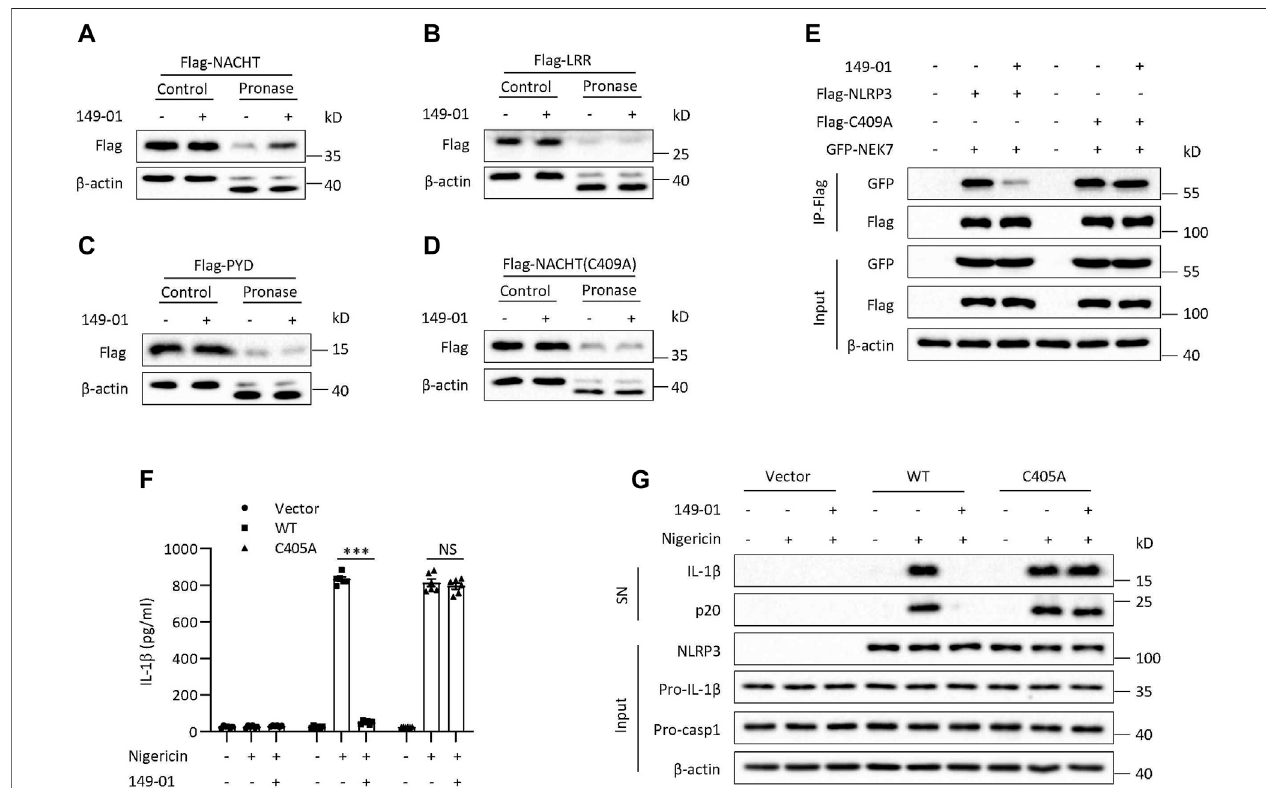
FIGURE5| 149-01targetsCys409ofNLRP3.HEK-293TcellstransfectedwithFlag-taggedNACHT (A) ,LRR (B) ,PYD (C) ,orNACHT(C409A) (D) werelysedand thecelllysatesincubated overnightwithorwithout149-01(80 μ M)beforepronasedigestionweredetectedbywesternblot. (E) TheinteractionsbetweenNEK7andWT or mutant NLRP3 in HEK-293T cells treated with or without 149-01 (3 μ M) were evaluated by IP and western blot. (F,G) Nlrp3 − / − BMDMs reconstituted with mouse WT or mutant NLRP3 were fi rst primed with LPS, then treated with or without 149-01 (600 nM) for 30 min, lastly stimulated with nigericin. (F) IL-1 β releases in supernatants were detected by ELISA. (G) Active IL-1 β and p20 in supernatants and NLRP3, pro-IL-1 β , pro-caspase-1 and β -actin in cell lysates were measured by western blot. Data are obtained from three independent experiments, each with two biological replicates and are expressed as mean ± s. e.m ( n = 6) (F) , or are representative of three independent experiments (A – E,G) . One-way ANOVA was applied to calculate statistical signi fi cance: *** p < .001, NS, not signi fi